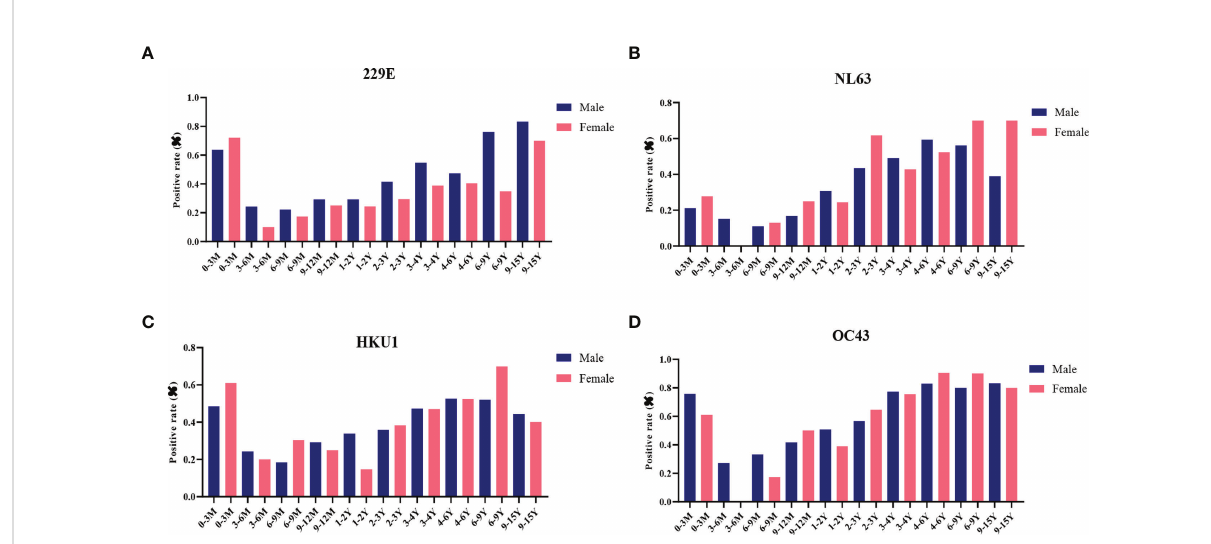
FIGURE 3 The effect of biological sex on pre-existing antibodies against LPH-CoVs in different age groups (A-D) The seropositive rates of HCoV-229E (A) , HCoV-NL63 (B) , HCoV-HKU1 (C) and HCoV-OC43 (D) in male and female individuals with different